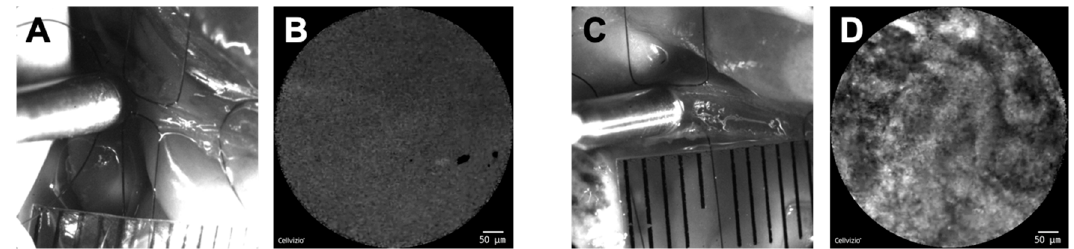
Figure 7. Confocal endomicroscopic imaging of the bile duct lumen of hamster. Administration of fLGs for 3 minutes followed by washout produced a homogeneous fluorescence pattern in normal bile duct lumen of a healthy hamster ( A , B ), whereas a highly heterogeneous pattern was detected in the lumen of a carcinogen BOP-administered hamster ( C , D ) at the same condition [184]. ( A ) and ( C ) represent the position of the confocal probe at the time of imaging. ( B ) and ( D ) represent corresponding confocal endomicroscopic images of the bile duct lumen. Scale bars in ( B ) and ( D ) represent 50 µ